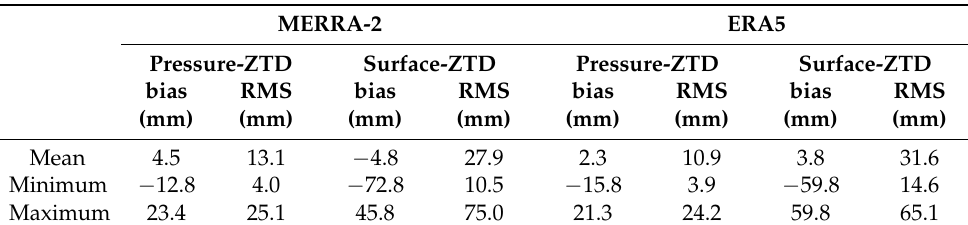
Table 1. Statistics on the bias and RMS for ERA5 and MERRA-2 ZTD from surface- and pressure-level data compared to GNSS ZTD from 2016 to 2017.